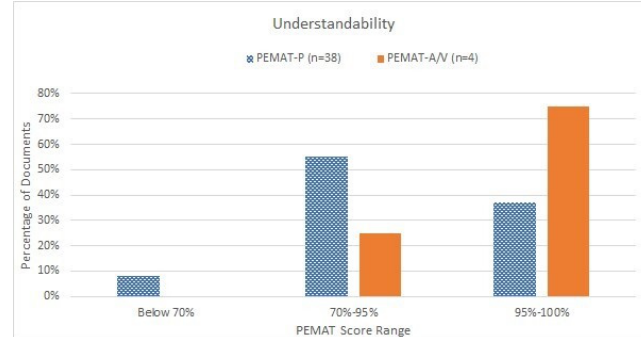
Figure 1 Distribution of materials by understandability assessment using PEMAT. A score of 70% or above is considered highly understandable, and a score below 70% indicates poor understandability